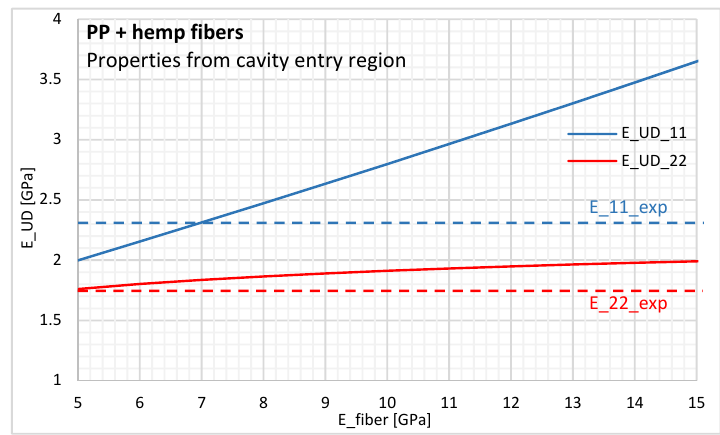
Figure 14. Young’s modulus of the unidirectional composite from the Tandon-Weng model with properties from the cavity entry region.